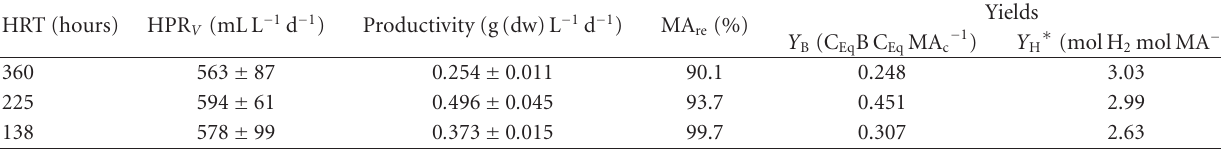
Table 1: Results achieved under continuous irradiance (480Wm − 2 ) at selected HRTs.